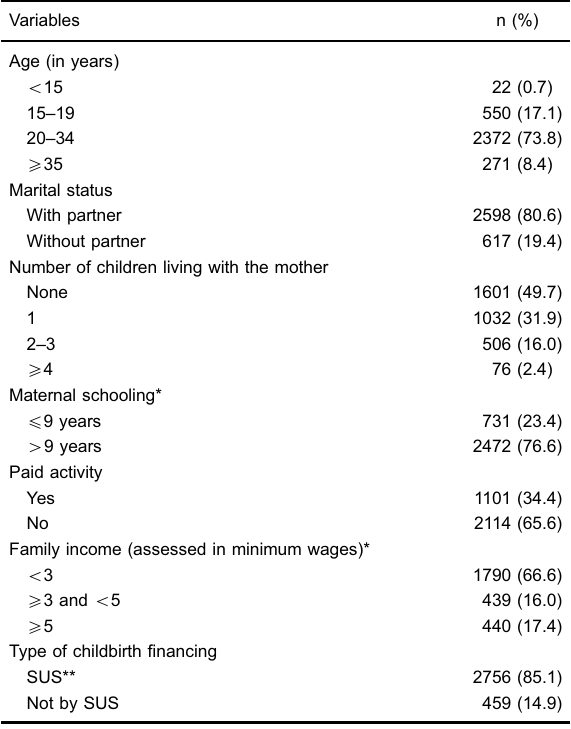
Table 1. Demographic and socioeconomic characteristics of the mothers from the BRISA Study, São Luís, 2013.